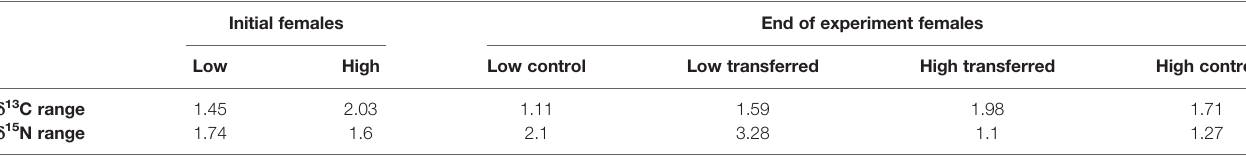
TABLE 1 | Range in d 13 C and d 15 N in female Monoporeia af fi nis from the two initial stations before the experiment, and females after the end of the experiment in the four treatments. Initial females End of experiment females Low High Low control Low transferred High